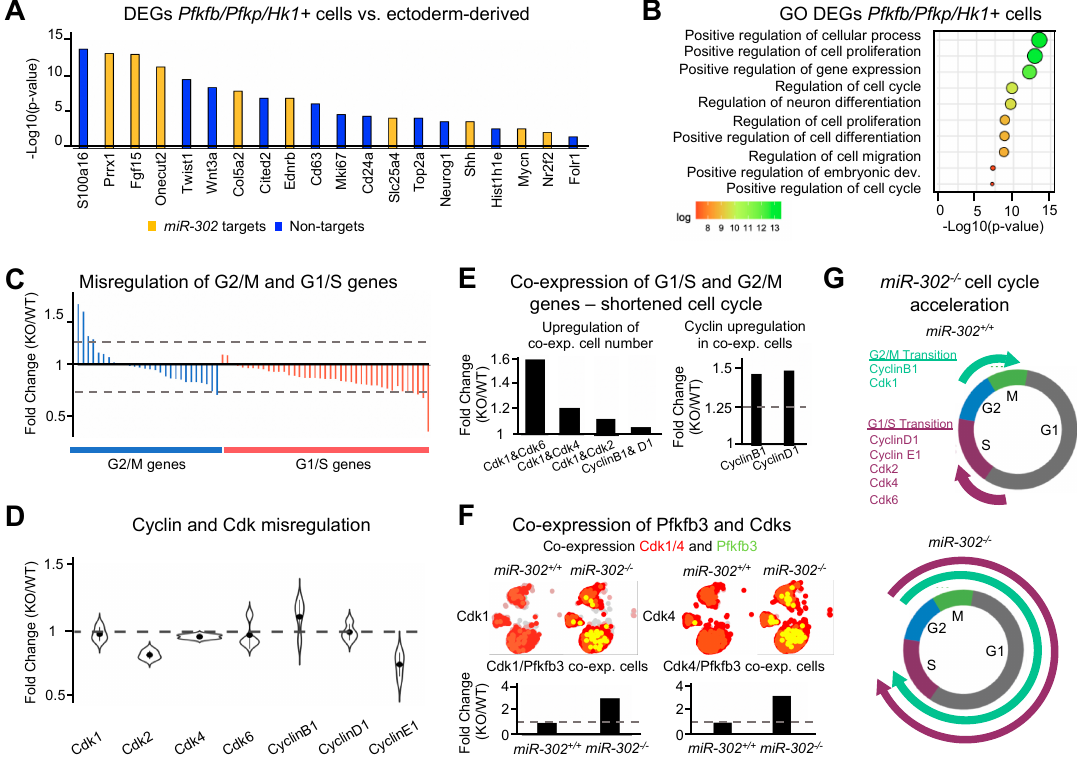
Figure 6. miR-302 targets Pfkp , Pfkfb3 , and Hk1 to regulate cell proliferation. ( A ) Representative di ff erentially expressed genes and ( B ) biological gene ontology analysis on the di ff erentially expressed genes obtained from comparing the cells within ectoderm-derived populations expressing Pfkp , Pfkfb3 , or Hk1 to ectoderm-derived and non-ectoderm-derived cells at E9.5. ( C ) Bar plot of misregulation of genes upon miR-302 deletion that promote the G2 / M and G1 / S phase transitions. ( D ) Violin plot of misregulation of Cyclin and Cdk genes of the miR-302 knockout. ( E ) Bar plots showing number of cells and cyclin expression in cells that co-express G1 / S and G2 / M genes. ( F ) Blended UMAP plot and bar plot to show number of cells co-expressing Pfkpfb3 with both Cdk1 and Cdk4 . ( G ) Schematic of co-expression of cell cycle transition genes and increased proliferation of the miR-302